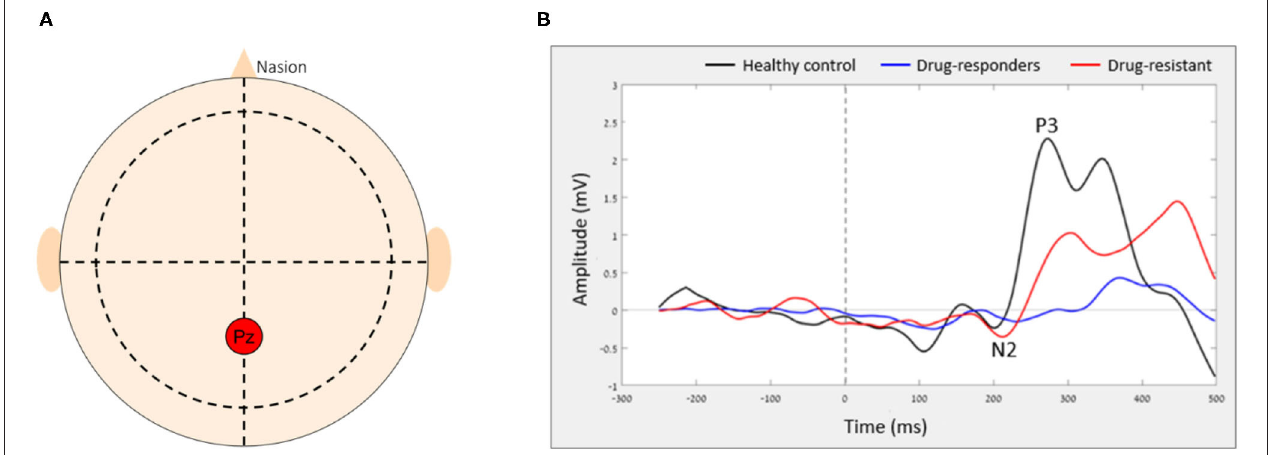
FIGURE 1 | The average ERP of each group in Pz electrode. (A) The relative location of Pz electrode on the scalp and (B) the average ERP of each group.